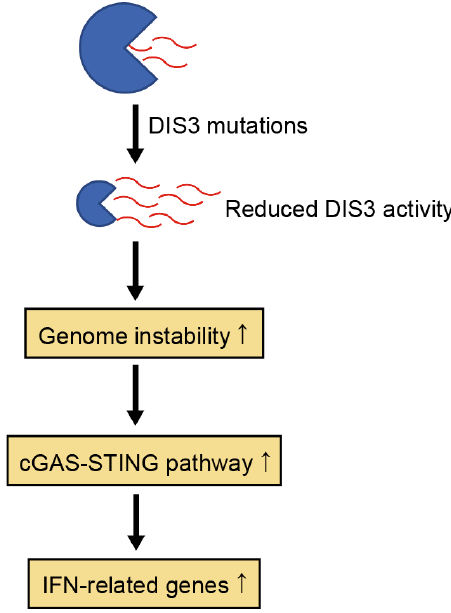
Figure 4. DIS3 mutations induce an interferon response. Reduced DIS3 activity increases genome instability, which may activate the cGAS-STING pathway, upregulating interferon (IFN)-related